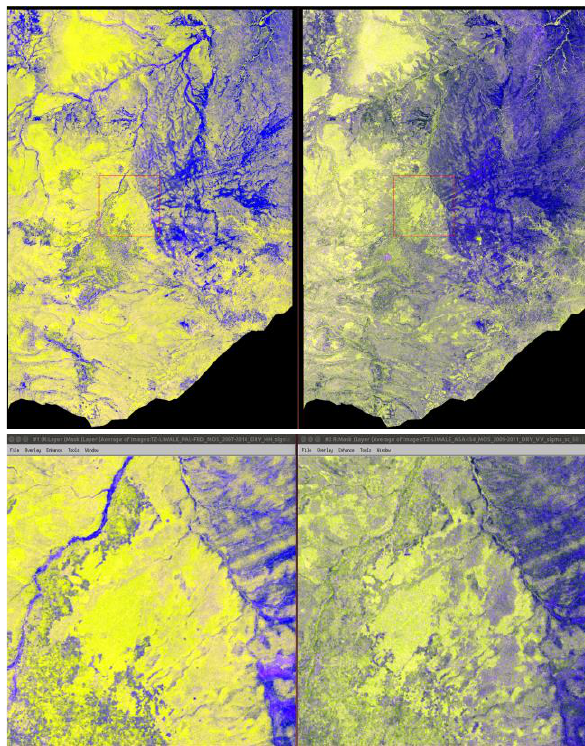
Figure 2. (Upper panels) 2007-2010 averaged ALOS Palsar Figure 3. Forest/Woodland/Non-forest classification from image (left) and 2009-2011 averaged Envisat ASAR APS image averaged ALOS Palsar FBD (left) and Envisat ASAR APS (right) over the Liwale study site. (Lower panels) red rectangle (right). Lower panels show the red rectangle zoom. Forest in zoom. dark green, woodland in light green, and non-forest in beige.